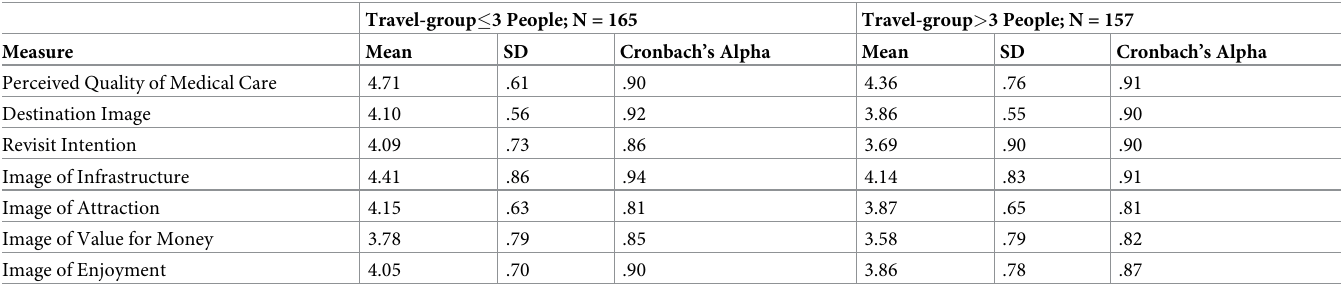
Table 6. Descriptive statistics and reliability analysis—Travel